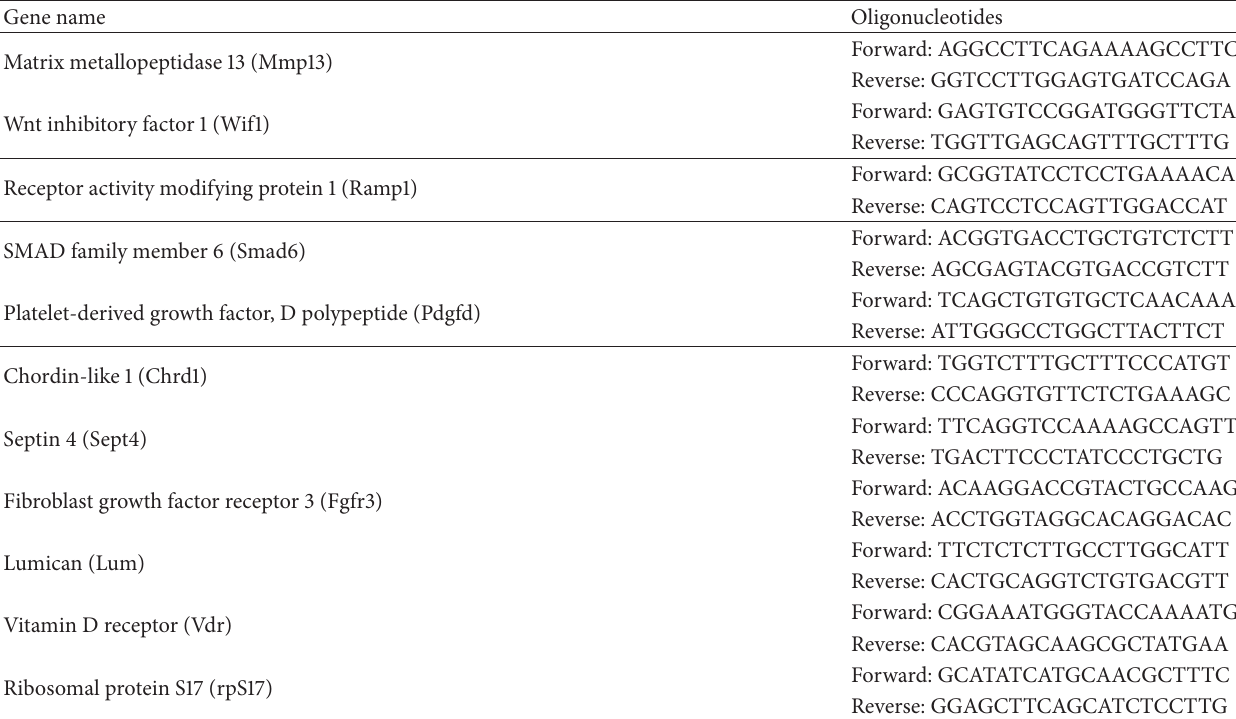
Table 1: Primers designed for RT-PCR analyses of genes related to cell proliferation and